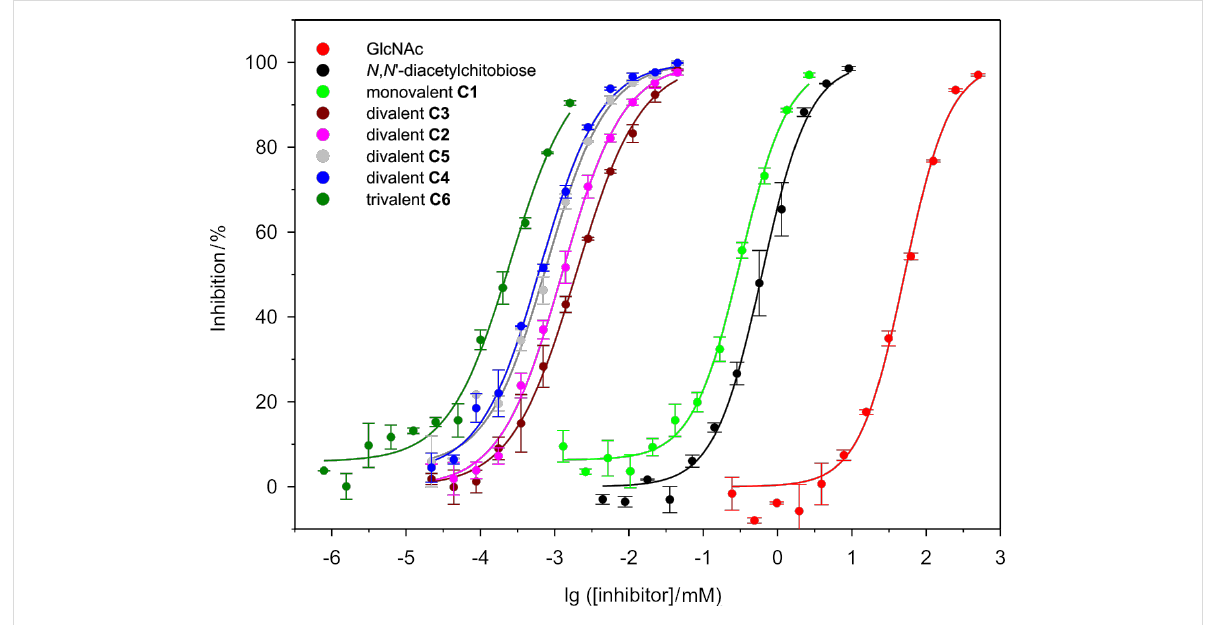
Figure 2: Dose-response curves for the inhibition of binding of HRP-labeled WGA to covalently immobilized GlcNAc by synthetic ligands C1 – C6 .